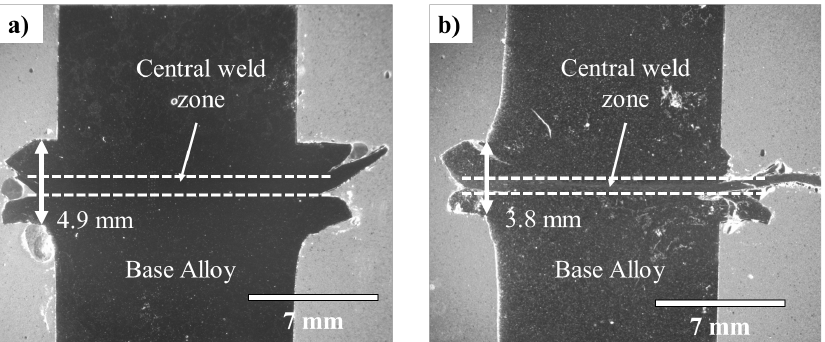
Figure 4. Stereoscopic images of the weld cross-sections ( a ) AZ91/AZ91 and ( b ) AZ91–2Ca/AZ91– 2Ca alloys. The dotted lines represent the boundaries of the weld